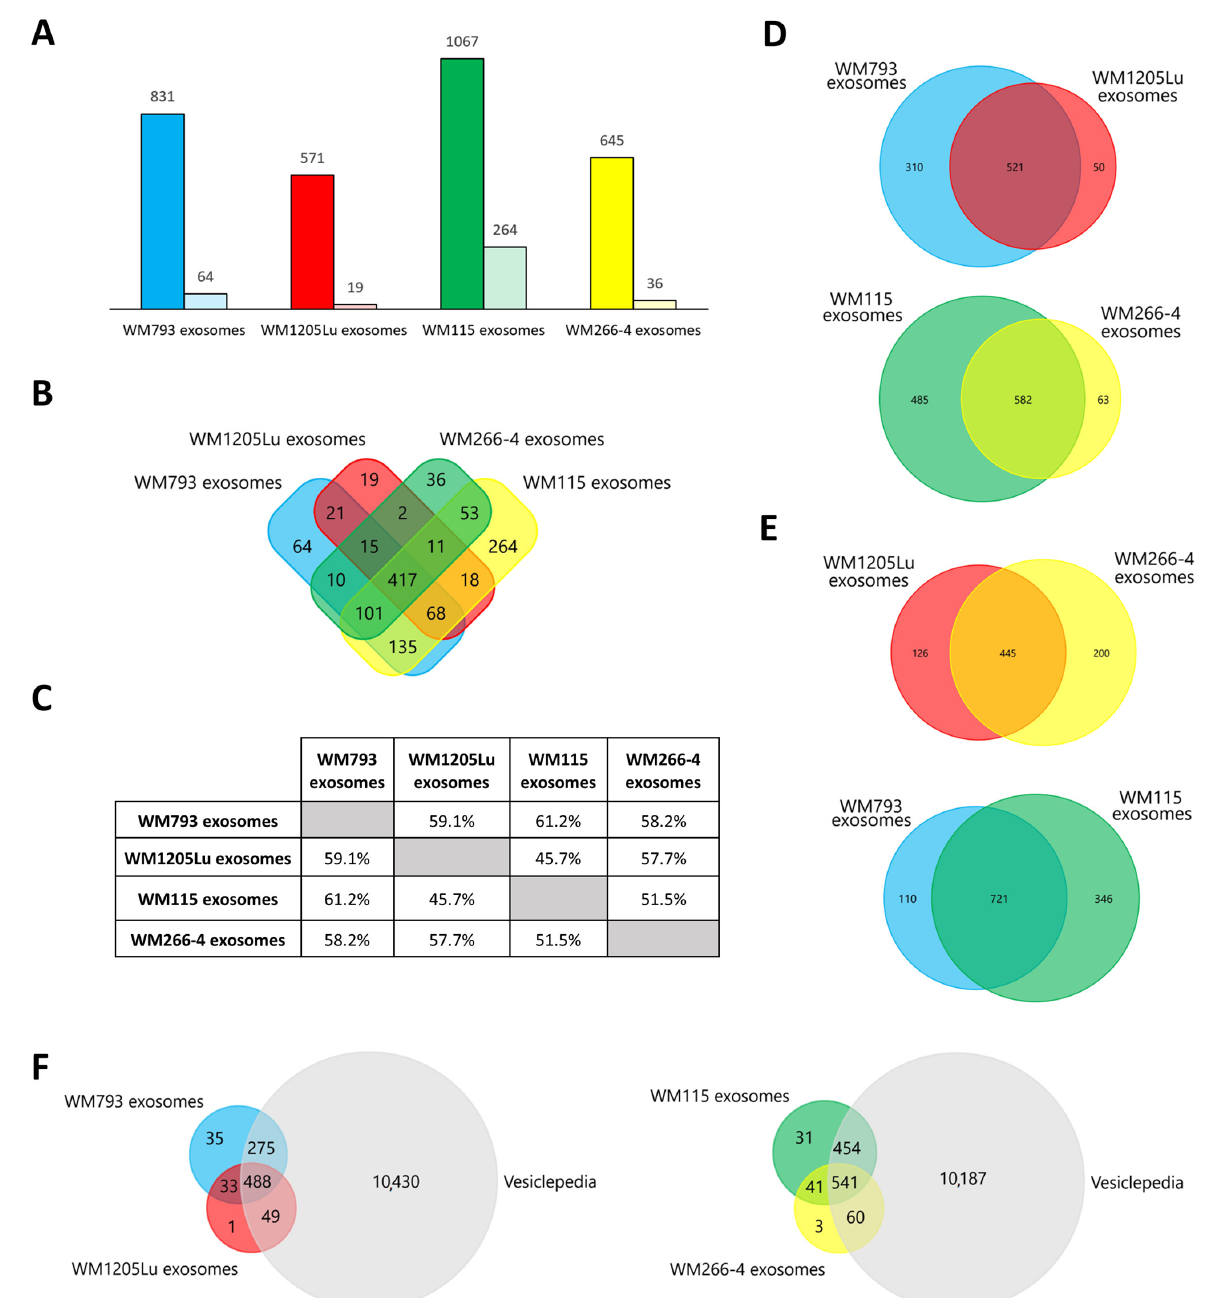
Figure 4. Qualitative analysis of proteins identified in CM-derived exosomes by LC-MS/MS. ( A ) Number of proteins identified (by at least two peptides) in at least three out of four biological replicates of each CM exosome sample (left bar) and the number of unique proteins (right bar). ( B ) Number of proteins shared between exosomes derived from given CM cell lines. ( C ) Percentage of proteins shared between given CM-derived exosome samples. Number of proteins shared between exosomes derived from isogenic ( D ) and primary or metastatic CM cell lines ( E ). ( F ) Venn diagram illustrating protein overlap between isolated ectosomes and Vesiclepedia database as a reference. WM115/WM266-4,WM793/WM1205Lu—isogenic pairs (primary/metastatic) of CM cell lines